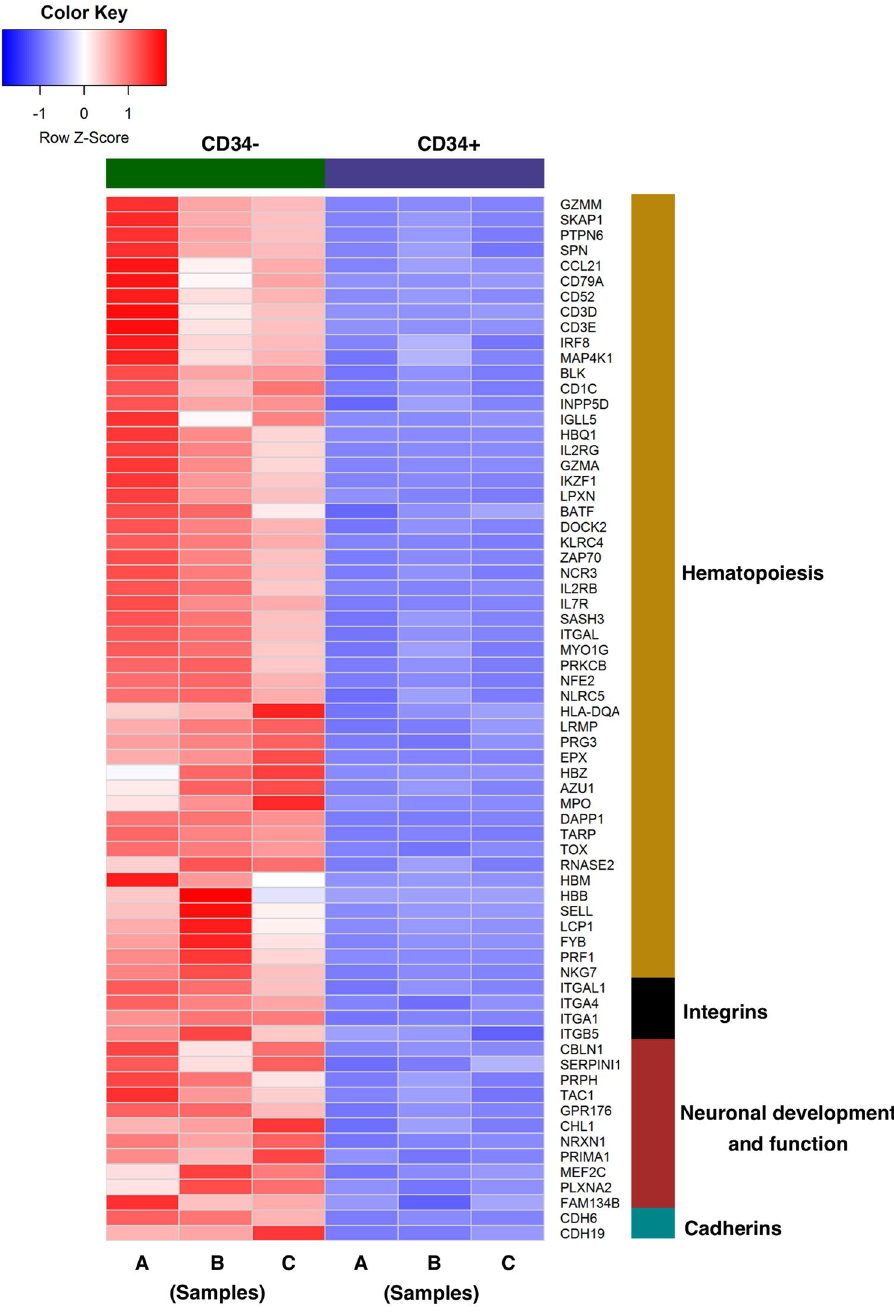
Figure 6. RNA sequence profiling of CD34 cells derived from human fetal SMGs. Heat map shows genes that are significantly downregulated in CD34 + population as compared to CD34 −